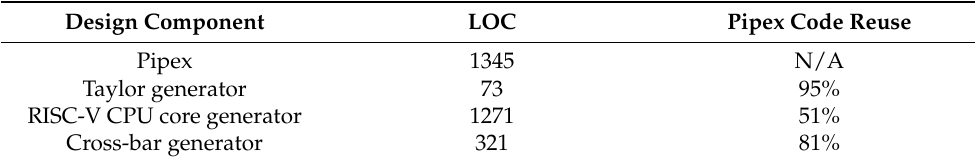
Table 2. Code reuse evaluation for Pipex and designs based on it.